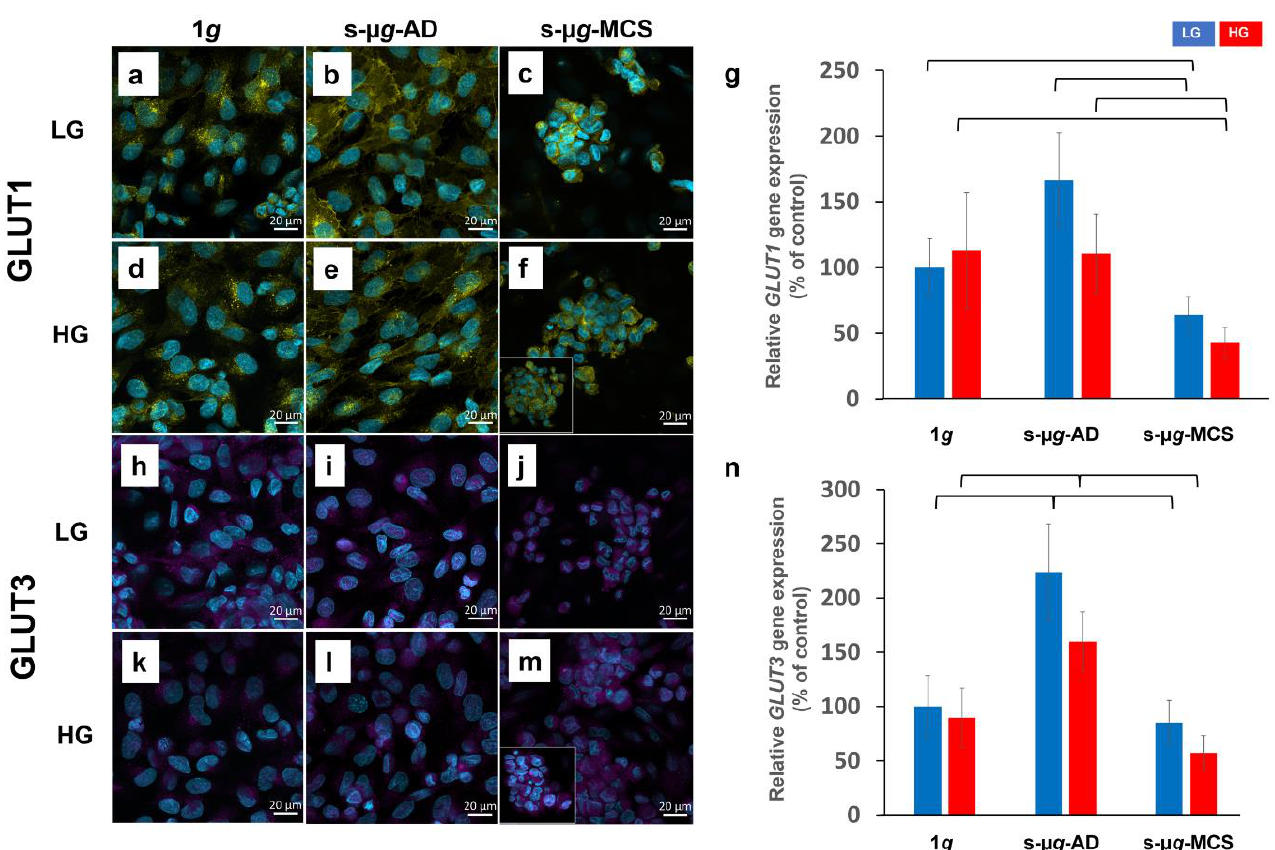
Figure 3. Analysis of glucose transporters GLUT1 and GLUT3 after 14 days of cultivation either at 1 g or s- µ g and either using low (LG) or high (HG) glucose medium. Immunostaining ( a – f , h – m ) and qPCR ( g , n ) results are represented. The brackets represent a significance level of p < 0.05. qPCR results of the GLUT1 gene expression exhibited a significant downregulation of GLUT1 between 1 g control and s- µ g -MCS and between s- µ g -AD and s- µ g -MCS in